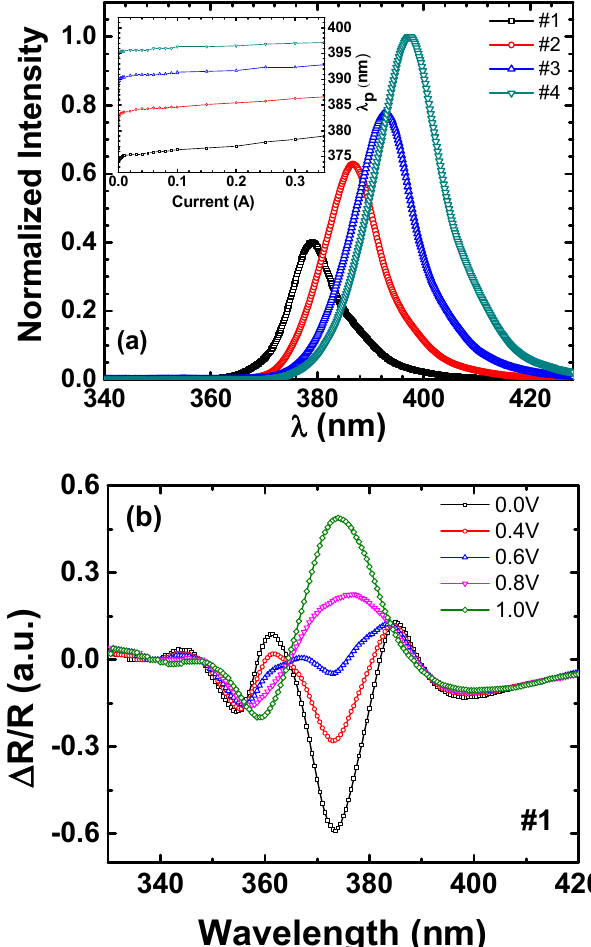
Figure 5. ( a ) Normalized electroluminescence (EL) spectra at 350 mA and room temperature, where all the samples’ peak intensities are normalized with respect to that of #4. The inset shows the peak wavelength characteristics. ( b ) Electroreflectance (ER) spectra at different biases for sample #1.